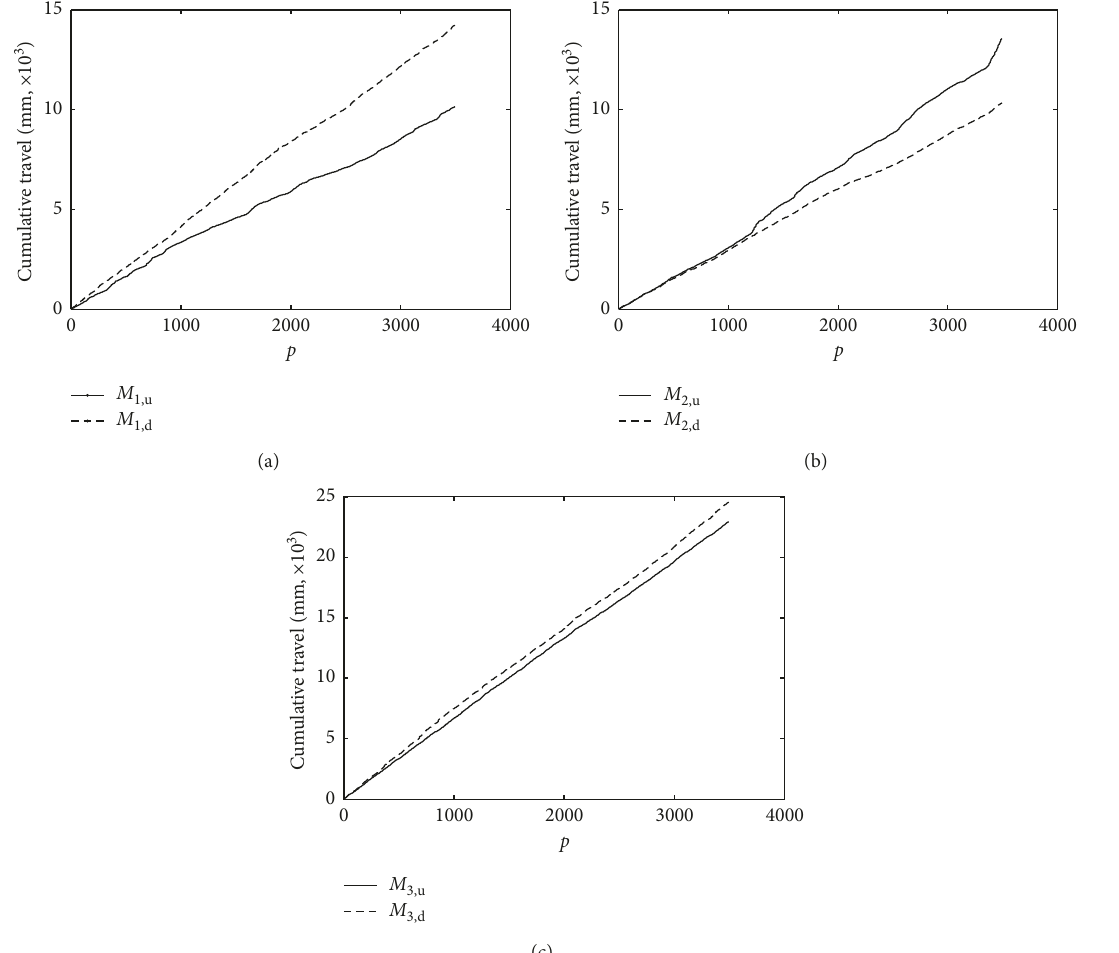
− M caused by many passed trains. (a) M 1 , u 3 , u